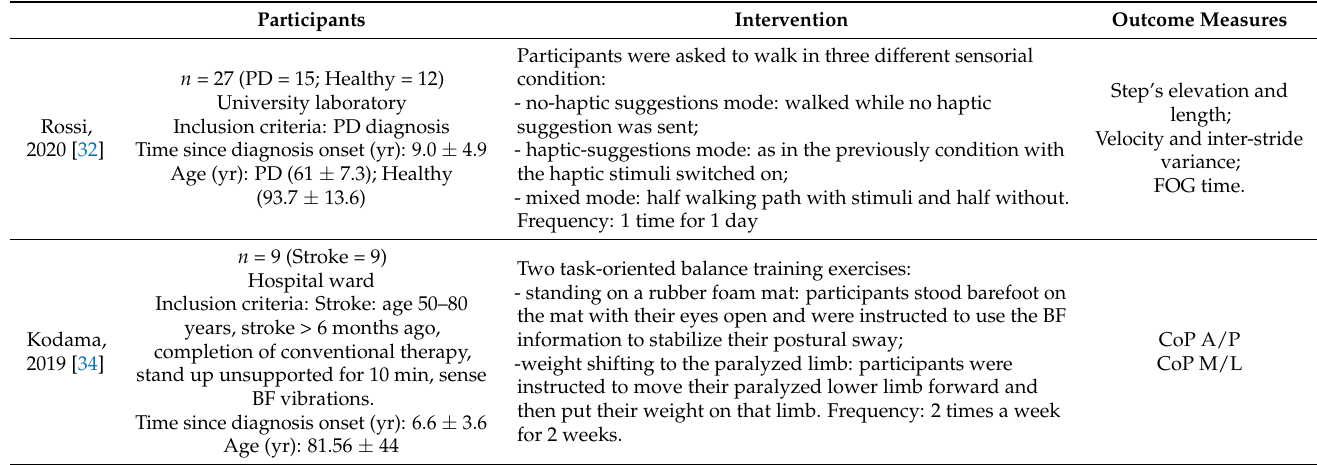
Figure 5. Forest plot of comparison: Overall effect of Vibrotactile feedback training in comparison to no-feedback interventions. Outcome: roll sway angle. Abbreviations: VTT, vibrotactile training; CI, confidence interval; SD, standard deviation [35,41]. Table 1. Description of included